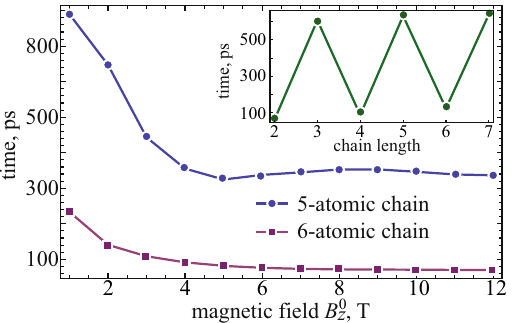
Figure 2. The evolution of relaxation time for 5-and 6-atomic chains locally perturbed at the edge by external magnetic field B z . Inset: Relaxation time for the set of Co n spin chains with n = 2.7 under magnetic field B